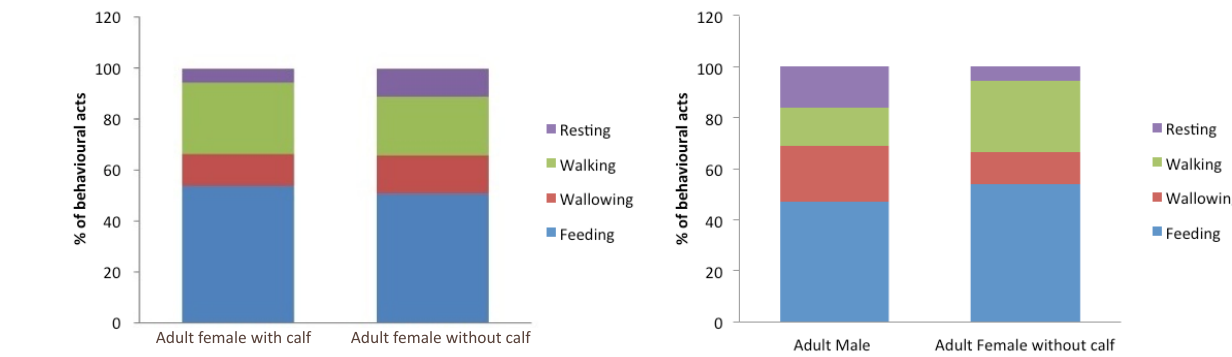
Figure 11. Adult female (with calf) and adult female (without calf) comparison of behavior